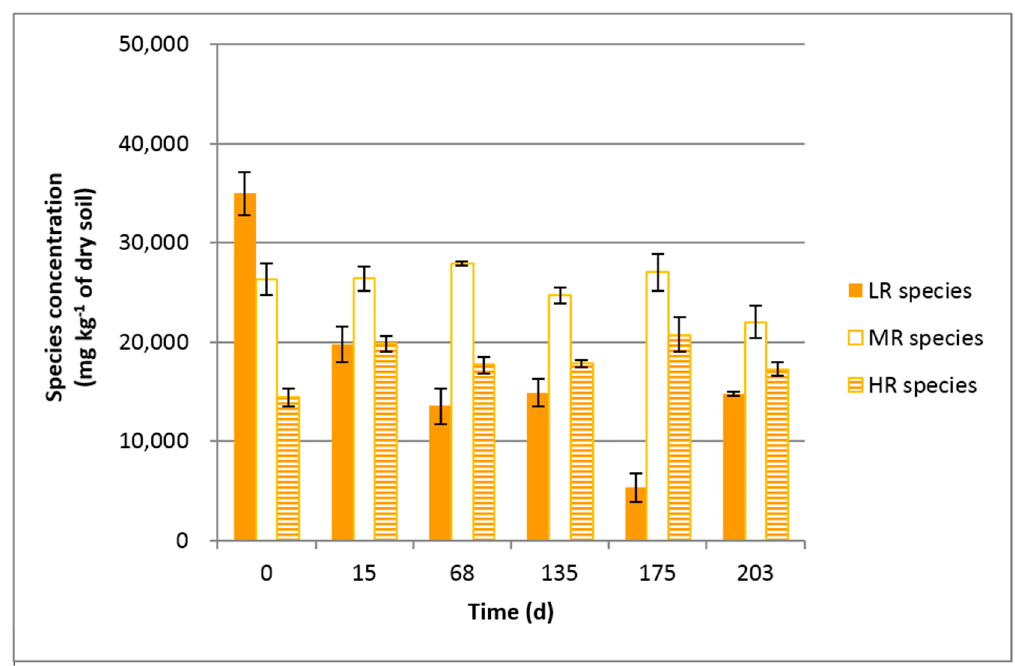
Figure 6. Change in residual diesel oil composition during the process for the abiotic microcosm.